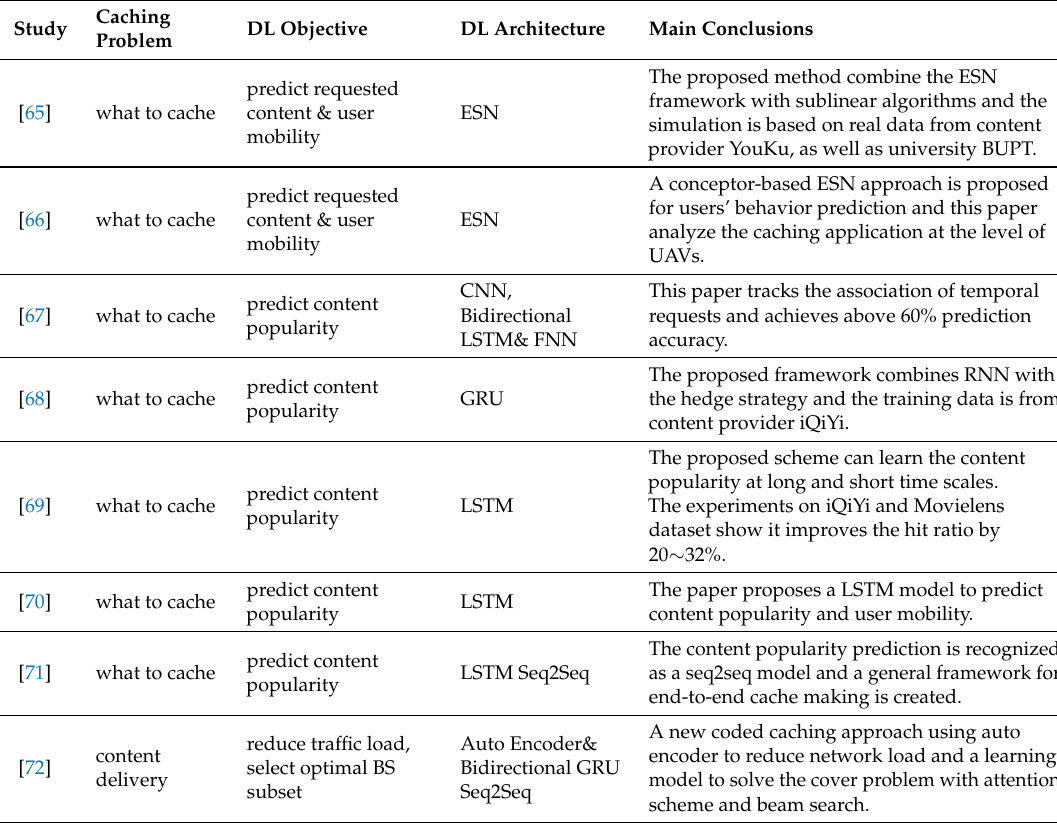
Table 4. Summary of recurrent neural network (RNN) for data